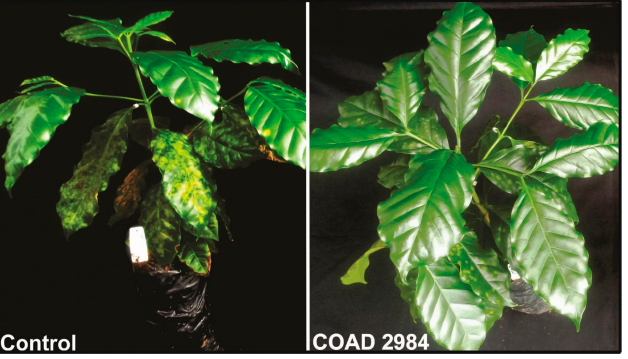
Figure 7. Evidence of reduction in disease severity via Clonostachys spp. after 60 days post-inoculation of Coffea arabica with Hemileia vastatrix : coffee plant grown in soil inoculated with sterile rice, leaves sprayed with sterile distilled water (control); coffee plant grown in soil inoculated with isolate-colonized rice plus sprayed with conidial suspension of C. rosea (COAD 2984). Note the smaller number of yellow spots on the adaxial surface in the COAD 2984-treated plant. severity in both assays—were evaluated for their ability to inhibit germination of H. vastatrix urediniospores. Germination of H. vastatrix urediniospores after exposure to Clonostachys suspensions was drastically reduced and ranged from total inhibition to up to 6%, depending on the Clonostachys isolate involved. COAD 2982 ( C. rhizophaga ), COAD 2984 ( C. rosea ) and COAD 2981 ( C. rhizophaga ) inhibited urediniospore germination by 94, 99 and 100%, respectively. Exposure to filtrates of the same isolates resulted in urediniospore germination dropping to 21–40%, depending on the Clonostachys isolate involved. COAD 2984 ( C. rosea ), COAD 2982 ( C. rhizophaga ) and COAD 2981 ( C. rhizophaga ) inhibited urediniospore germination to 60, 67 and 79%, respectively. Similarly, to what was shown by Salcedo-Sarmiento [42], distortions of the germ tubes were also observed when H. vastatrix urediniospores were exposed to both conidial suspensions and filtrates of Clonostachys (Figure 8).